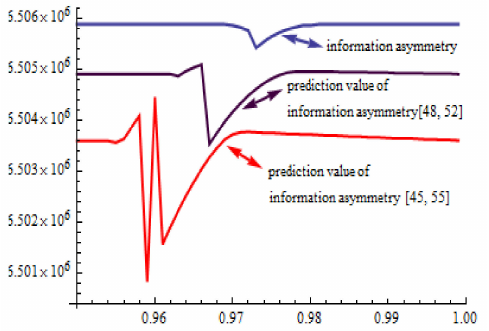
Figure 5. Trend chart of the expected revenue of the supply